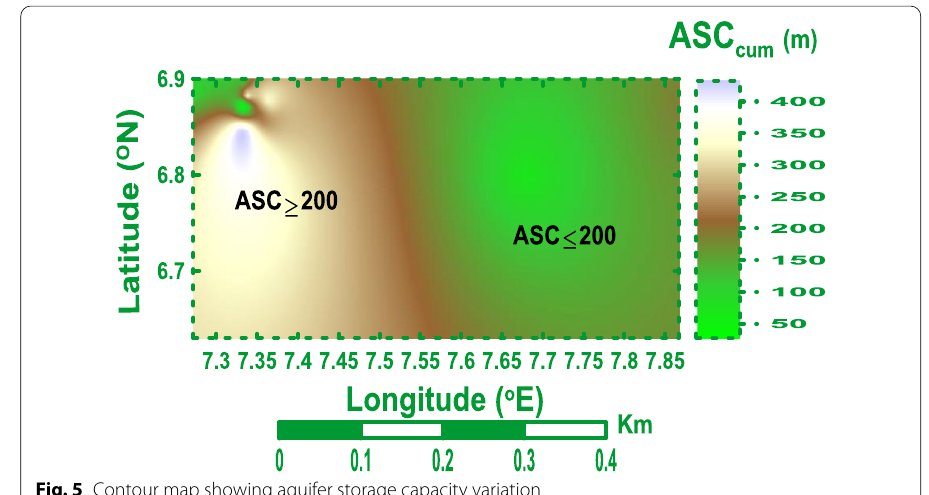
Fig. 5 Contour map showing aquifer storage capacity variation